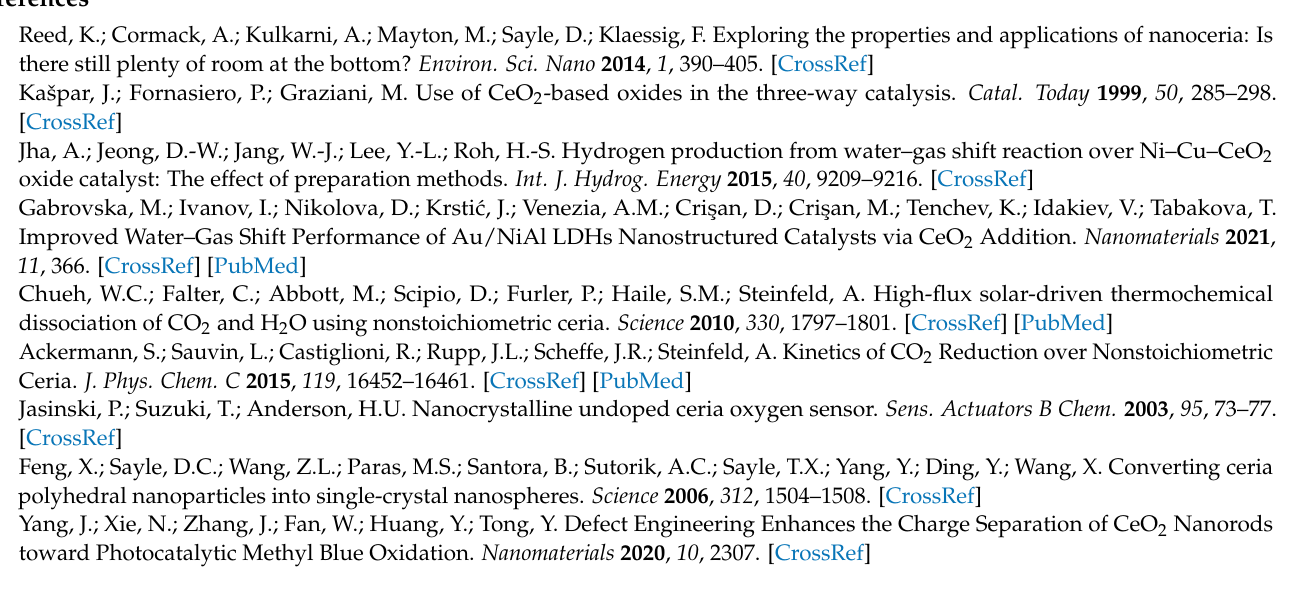
Figure S2. Color variation of P-CeO 2 , C-CeO 2 and R-CeO 2 (from left to right) calcining in different atmospheres: ( a ) raw samples without annealing, ( b ) air, ( c ) 30% H 2 , ( d ) 60% H 2 , and ( e ) pure H 2 condition. Figure S3. O 1s spectra of P-CeO 2 (a), C-CeO 2 ( b ) and R-CeO 2 ( c ) calcining in different concentration of H 2 . Figure S4. TEM images and size distribution of P-CeO 2 calcining in air ( a – c ) and H 2 ( d – f ) at 600 ◦ C. Figure S5. TEM images and size distribution of C-CeO 2 calcining in air ( a – c ) and H 2 ( d – f ) at 600 ◦ C. Figure S6. TEM images and size distribution of R-CeO 2 calcining in air ( a – c ) and H 2 ( d – f ) at 600 ◦ C. Figure S7. TEM images of raw R-CeO 2 ( a ), R-CeO 2 -Air ( b ) and R-CeO 2 -H 2 ( c ). Figure S8. The XRD patterns of C-CeO 2 annealed in air, 30%, 60% and pure H 2 . Figure S9. Nitrogen adsorption–desorption isotherms of the P-CeO 2 ( a ), C-CeO 2 ( b ), and R-CeO 2 ( c ) calcining in air or pure H 2 . Table S1. Synthetic conditions of raw P-CeO 2 , C-CeO 2 and R-CeO 2 . Table S2. Ce 3+ and absorbed oxygen concentration of P-CeO 2 , C-CeO 2 and R-CeO 2 calcining in different concentration of H 2 . Table S3. Photocatalytic degradation ratio and rate constants of P-CeO 2 , C-CeO 2 , and R-CeO 2 calcining in different atmospheres. Table S4. The calculated crystal size of C-CeO 2 annealed in air, 30%, 60% and pure H 2 . Table S5. Energy band gap, calculated valence and conductive band, tested valence and conductive band of P-CeO 2 , C-CeO 2 , and R-CeO 2 calcining in different concentration of H 2 . Table S6. Average current density ( µ A/cm 2 ) of P-CeO 2 , C-CeO 2 , and R-CeO 2 calcining in different concentration of H 2 . Table S7. Offset values of photodegradation ratio, band gap and photocurrent density of different hydrogen annealed